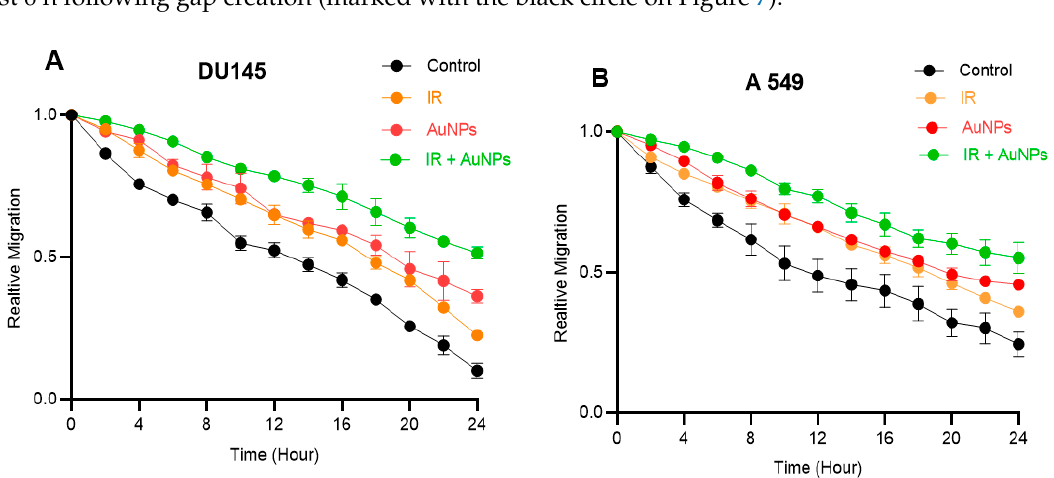
Figure 7. E ff ect of IR and / or AuNPs on the relative migration of DU145 and A549 cells in vitro. ( A ) DU145 (prostate) and ( B ) A549 (lung) cancer cells; the first 6 h is marked with the circle. Results expressed as the mean ± SEM of 3 replicates.